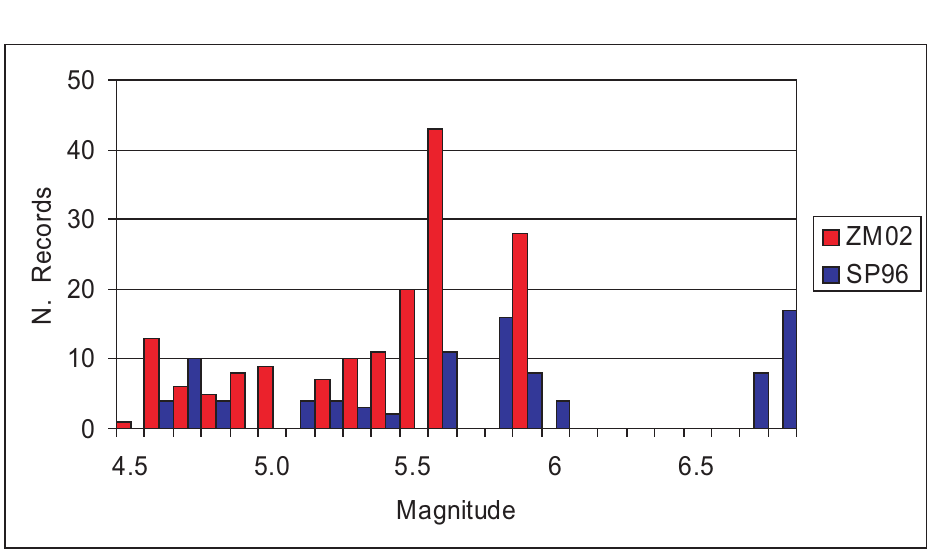
Fig. 1. The histogram shows the number of data used in this study (ZM02) and in SP96 for each magnitude level. Data for SP96 are obtained from Sabetta and Pugliese